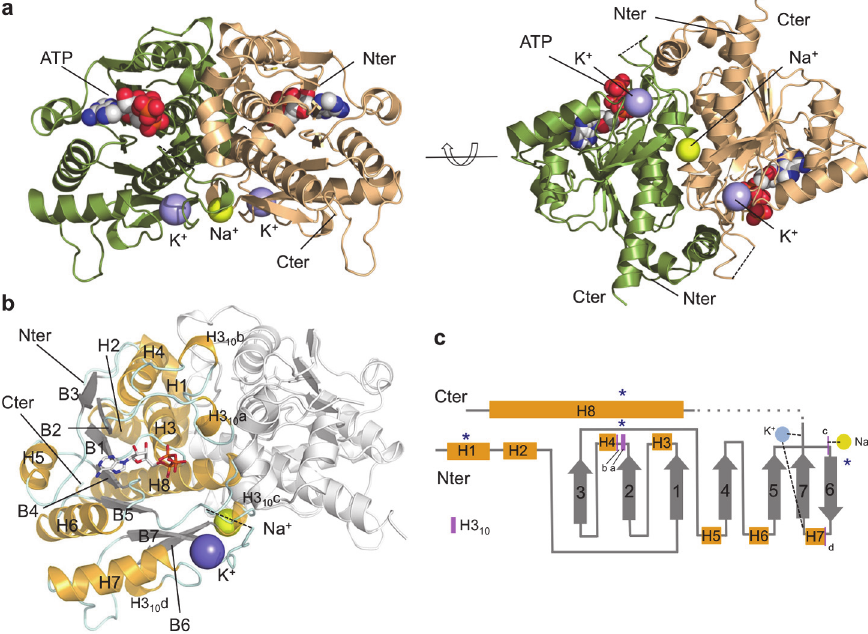
Fig 2. X-ray crystallographic structure of the binary complex TcdA at 1.77- Å resolution in complex with ATP. a Ribbon representation of the TcdA homodimer structure in two orientations related by a 90° rotation depicting each subunit in a different color (green or wheat). Two K + and one Na + cations are shown as violet and yellow spheres, respectively. The Na + ion is located right at the homodimeric interface and its coordination sphere comprises amino acid residues from both monomers and water molecules. ATP is bound in a conserved surface pocket (shown as a space-filling model in CPK colors). b Description of secondary structural elements of TcdA monomer. Helices are shown in gold ( α -helices are labeled H1-H8 and 3 10 helices H3 10 a-d), strands in white (B1-B7), and loops in light cyan. c Annotated schematic representation of TcdA topology. Helices and strands are depicted as in b , except for 3 10 helices which are indicated with purple lines and labeled a-d. K + and Na + ions are shown as blue and yellow circles. Dashed lines delimit regions that interact with K + , and structures involved in TcdA dimerization are marked with dark blue